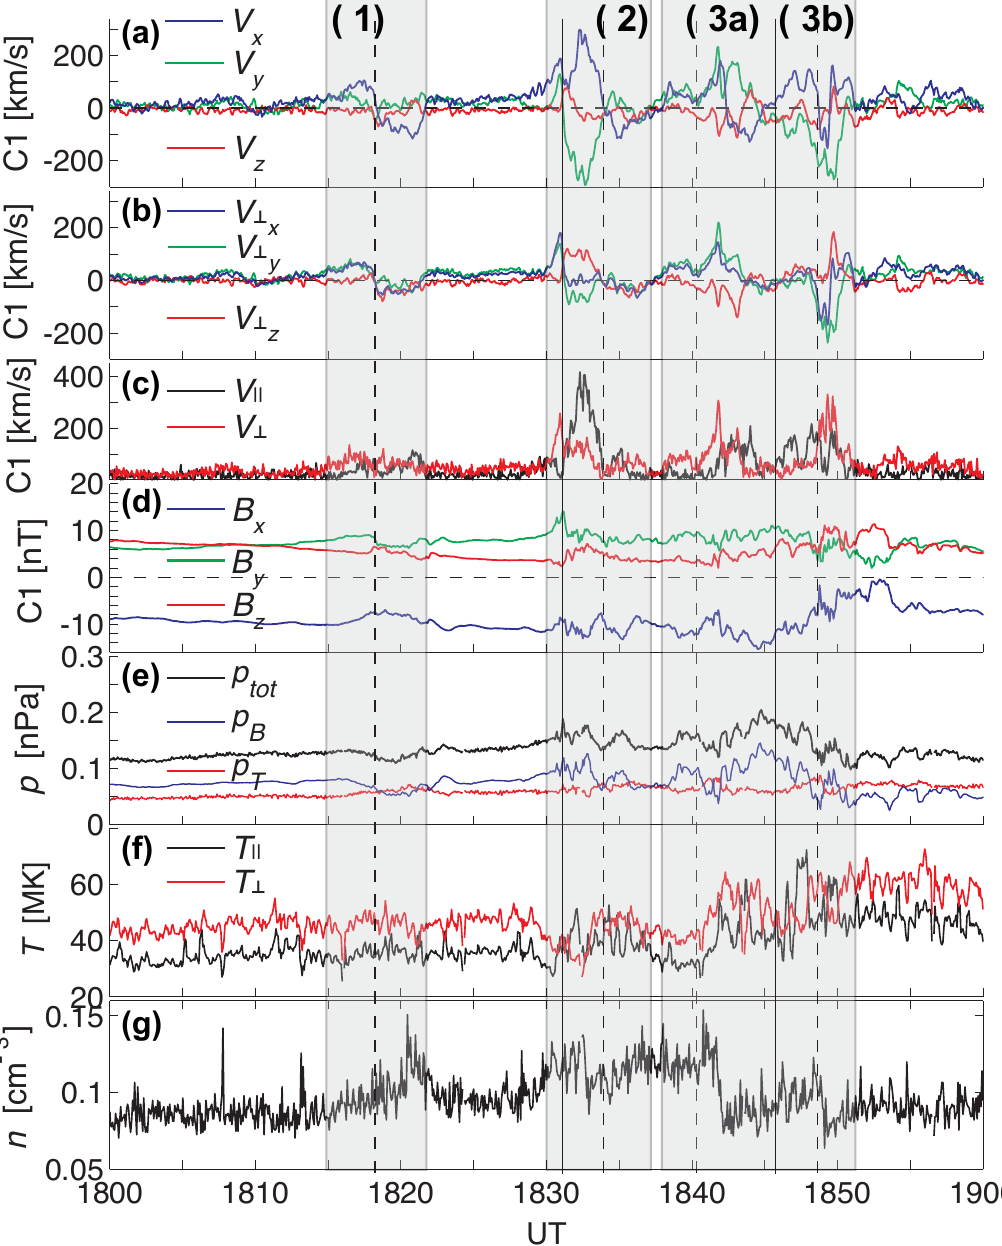
Fig. 5. Cluster C1 data. (a) CIS HIA total velocity in GSM. (b) CIS HIA velocity perpendicular to the magnetic field. (c) Magnitudes of the parallel and perpendicular velocity. (d) Magnetic field. (e) Total pressure (black), thermal pressure p T = nk B (T k + 2 T ⊥ )/ 3 (red) and magnetic pressure p B = B 2 /( 2 µ 0 ) (blue). (f) Parallel ( T k ) and perpendicular ( T ⊥ ) temperatures used in thermal pressure calculation. (g) Ion density. The vertical grey-shaded strips indicate the BBF events under study. Solid vertical lines mark the start of the proper flow of a BBF at C1. Dashed vertical lines mark major changes in the flow, see details in the text.